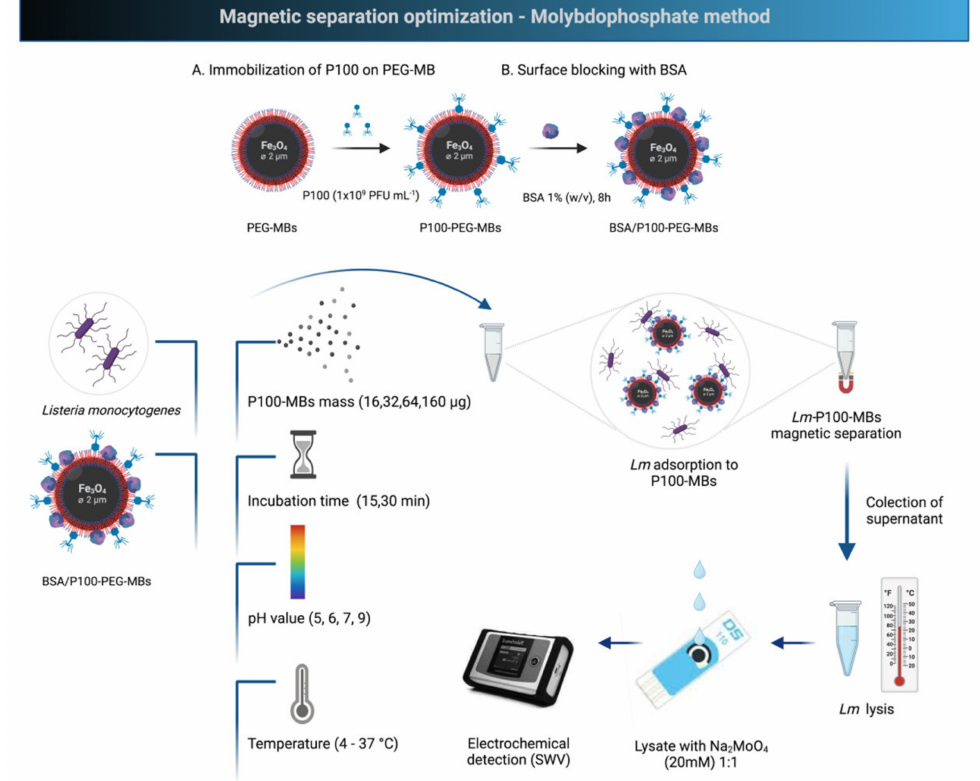
Figure 1. Schematic illustration of the optimization of the phagomagnetic separation protocol resorting to the molybdophosphate